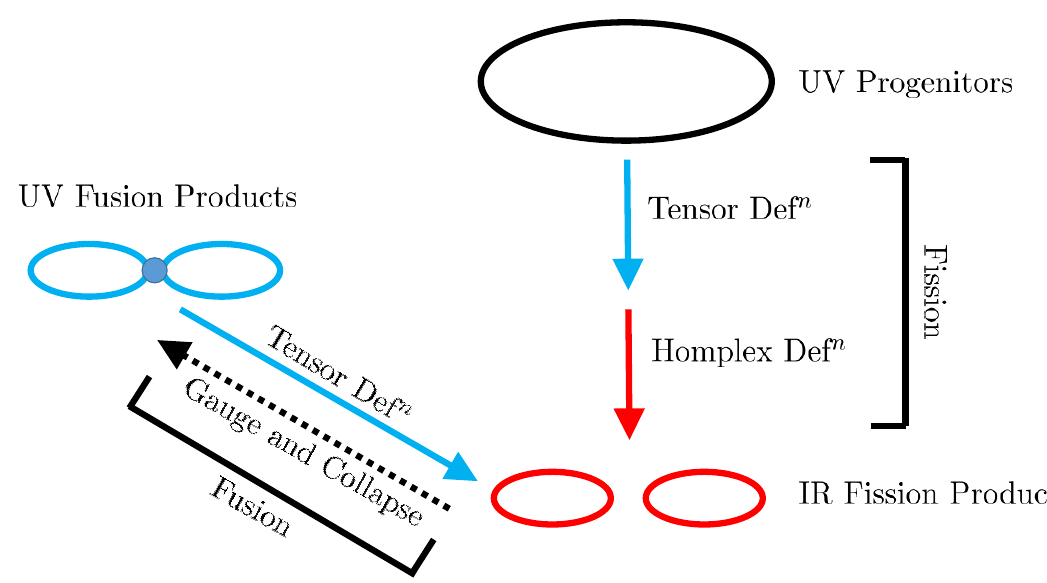
Figure 1 . Depiction of (cid:12)ssion and fusion for 6D SCFTs. Fission consists of (cid:12)rst performing a tensor branch deformation, which is then followed by a specialized Higgs branch deformation associated with either a continuous su (2) ! g (cid:13)av homomorphism or a homomorphism (cid:0) ADE ! E 8 , with (cid:0) ADE a (cid:12)nite subgroup of SU(2). In F-theory, these specify a restricted class of complex structure deformations which we refer to as \homplex deformations". Fusion corresponds to gauging a (cid:13)avor symmetry of at least one, but possibly several decoupled 6D SCFTs and pairing this gauge symmetry with a tensor multiplet. A new SCFT is generated by tuning this new tensor multiplet to the origin of moduli space. Quite surprisingly, all 6D SCFTs can be obtained from a single (cid:12)ssion step or as the fusion of (cid:12)ssion products obtained from a small number of UV progenitor theories. Moreover, in a sense we will make precise below, almost all theories can be generated by (cid:12)ssion